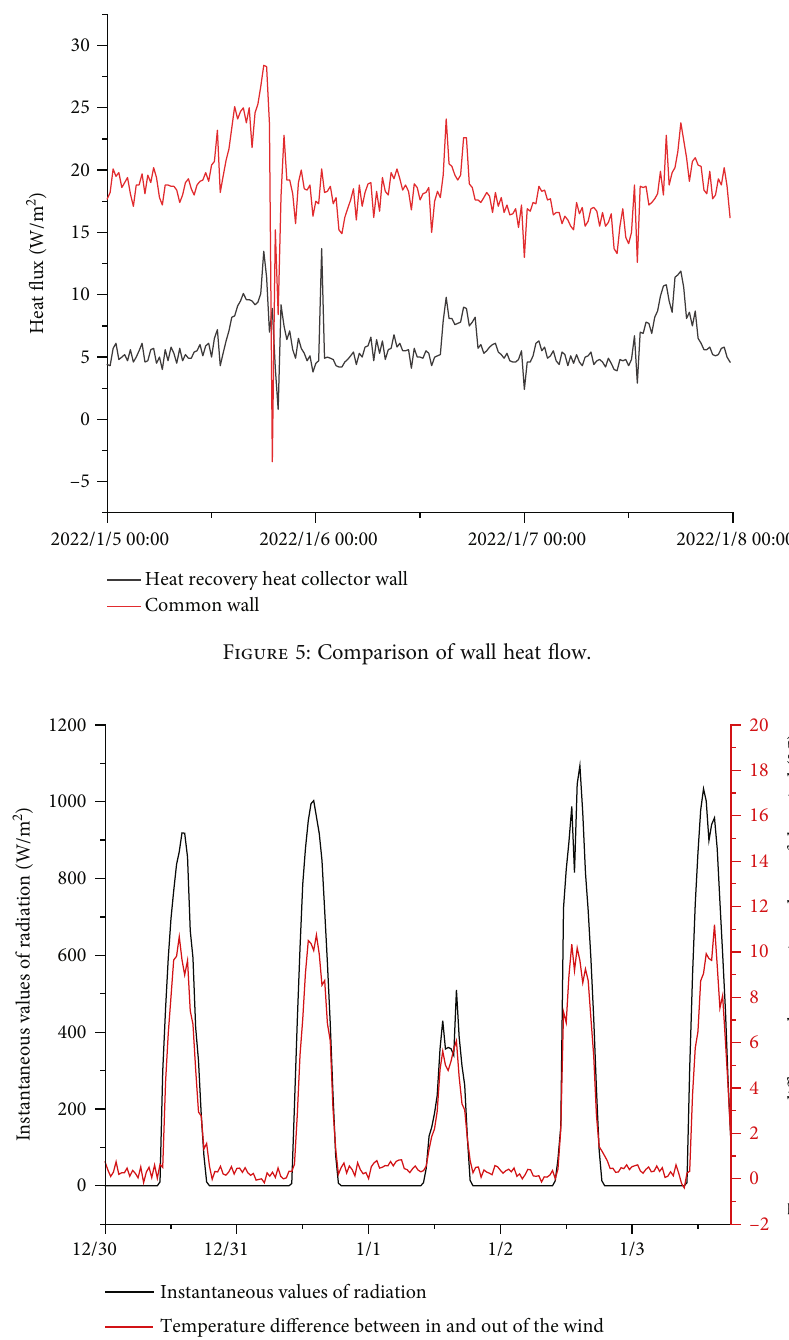
Figure 6: Temperature di ff erence between inlet air and outlet air and solar